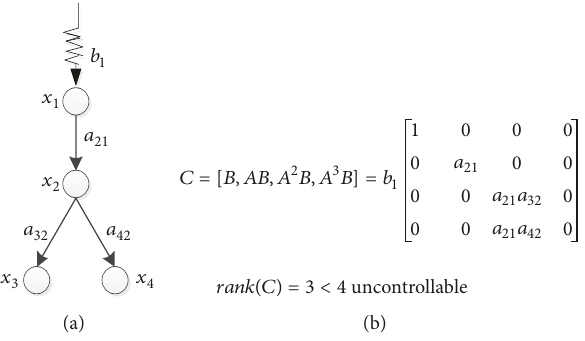
Figure 2: Schematic diagram of uncontrollable system